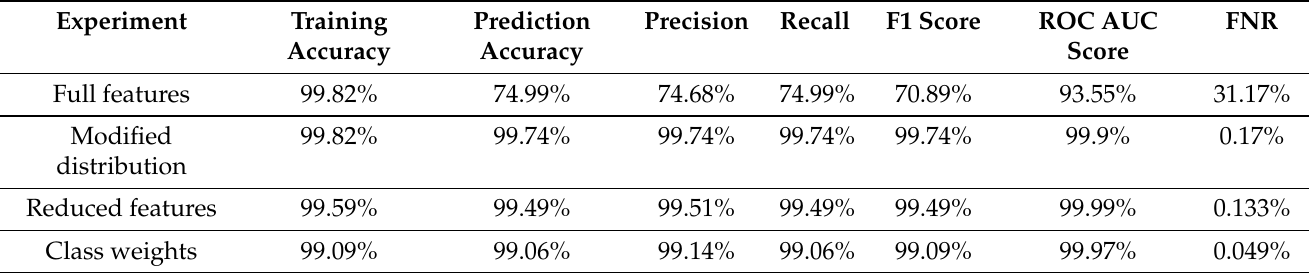
Table 21. Comparison of the results achieved in the NSL-KDD multiclass classification